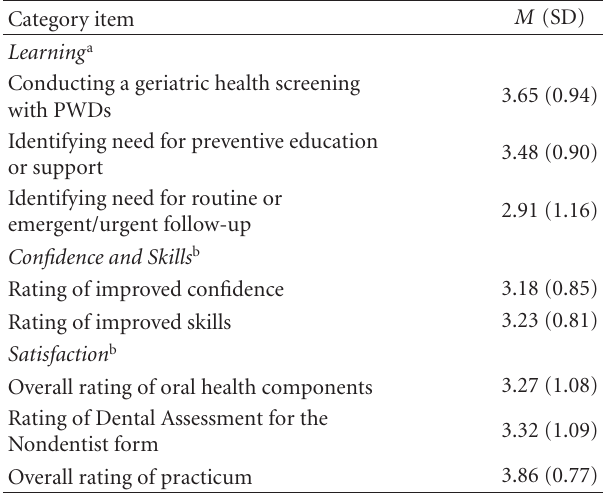
Table 5: Gerontological nurse practitioner evaluation of practicum using evaluation tool.